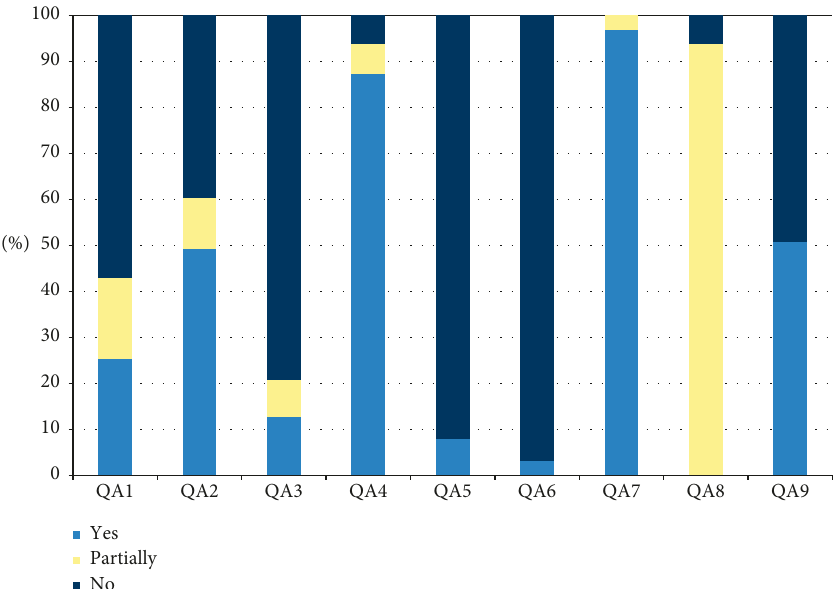
Figure 5: QA criteria by number of studies and by type (Y, P, or